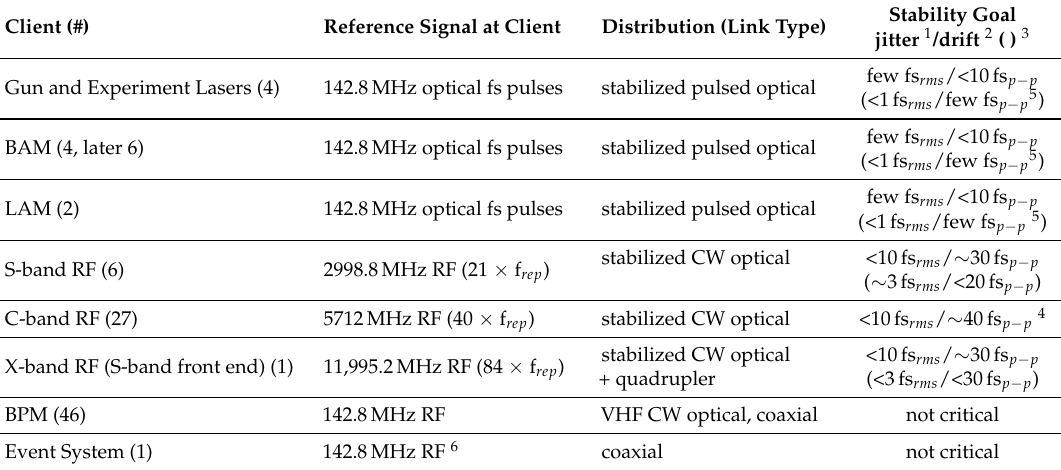
Table 5. The clients of the Timing Reference Distribution, the types of links and their stability